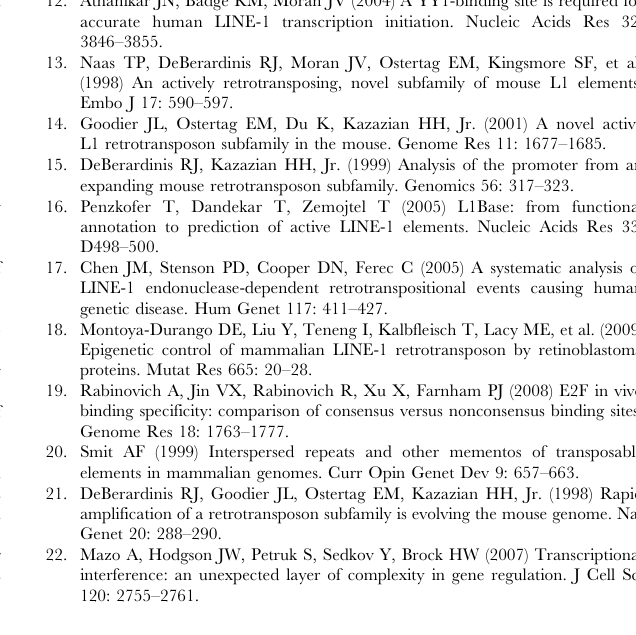
Figure 10. Relative luciferase activity of each T F promoter is shown after normalized for Renilla luciferase reporter. In this assay, the negative control GL3 vector was used. The arbitrary units of each relative luciferase activity are converted into the percentage. Error bars show s.d. of three independent experiments *P , 0.001. The bottom panel shows the characteristic features of each TF